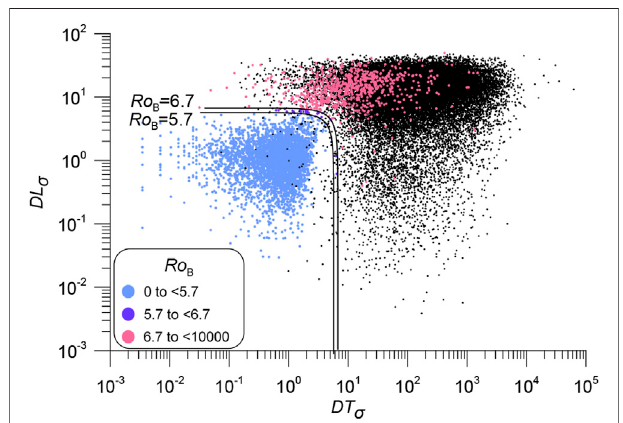
FIGURE 8 | Spatio-temporal structure of duplicates and aftershocks. Colored dots are JMA/ANSS pairs, black dots are the distance between aftershocks from the JMA catalog in the basic metric Ro B (Eq. 4) . Metric level lines Ro B (cid:2) 5 . 7 and Ro B (cid:2) 6 . 7 provide close to optimal separation of duplicates and aftershocks. DT σ (cid:2) DT / σ T , and DL σ (cid:2)